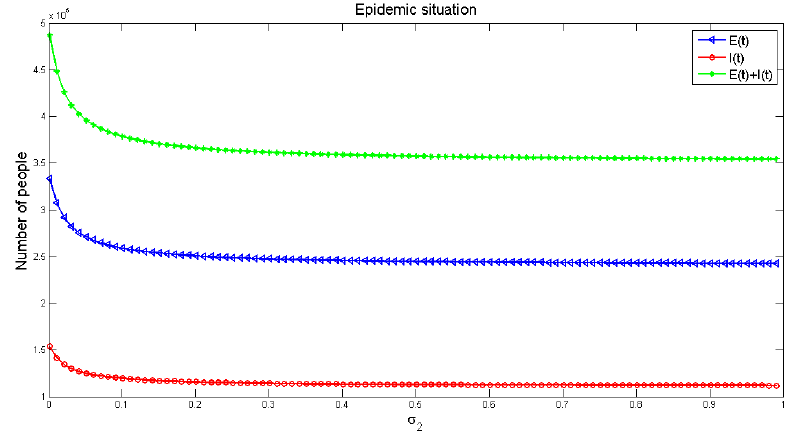
Figure 11. The influence of the probability ρ 2 from unconscious susceptible to conscious susceptible on the number of infected people.